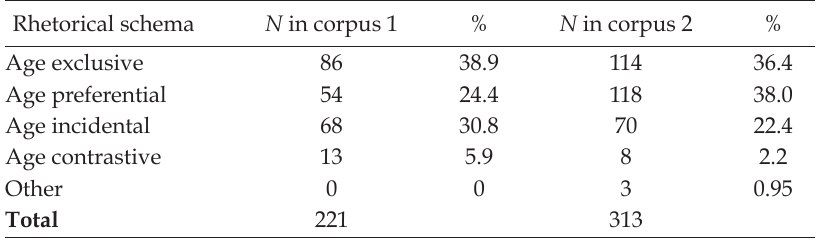
Table 4. Rhetorical schema in